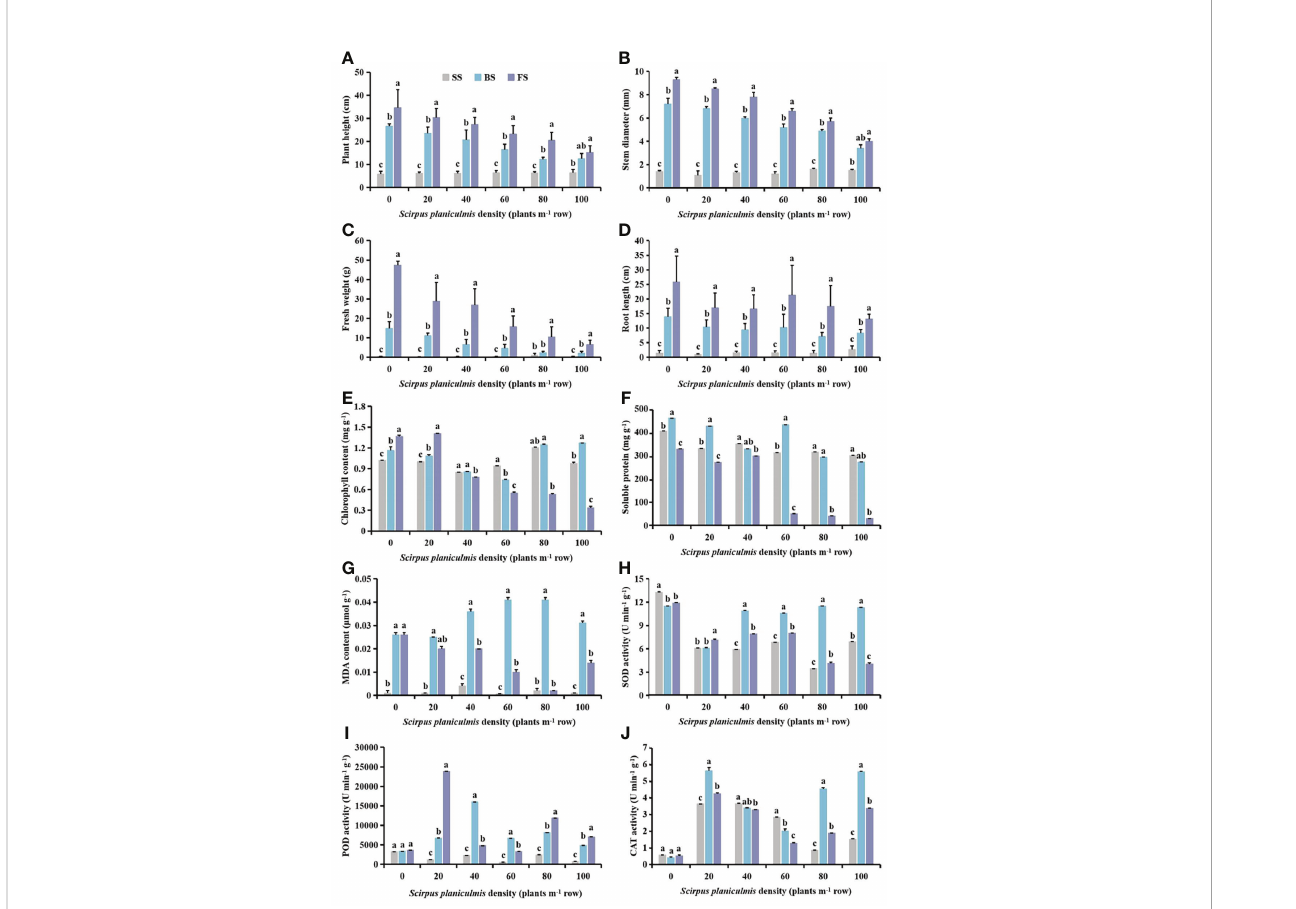
FIGURE 3 Under different Scirpus planiculmis densities, the (A) plant height, (B) stem diameter, (C) fresh weight, (D) root length, (E) chlorophyll, (F) soluble protein and (G) malondialdehyde (MDA) content, and (H) superoxide dismutase (SOD). (I) peroxidase (POD) and (J) catalase (CAT) activities of cotton at seedling, budding, and fl owering and boll stages, SS, seedling stage; BS, budding stage, FS, fl owering and boll stage. The mean value ± standard data were presented in the fi gure. Different alphabetical letters indicate the signi fi cant differences between different cotton growth stage ( p